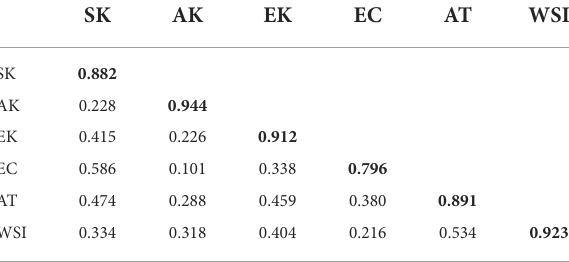
TABLE 3 The square root of AVE and factor correlation coefficients.